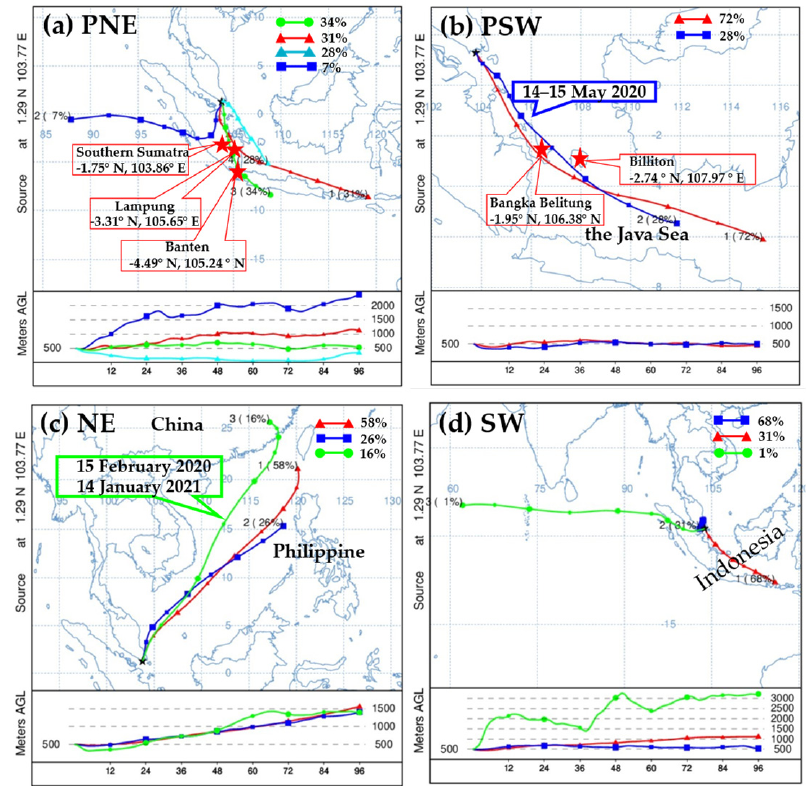
Figure 4. The cluster analysis of 96 h airmass backwards trajectories in four different seasons: ( a ) backwards trajectories air masses in PNE; ( b ) backwards trajectories air masses in PSW; ( c ) backwards trajectories air masses in NE; ( d ) backwards trajectories air masses in SW.